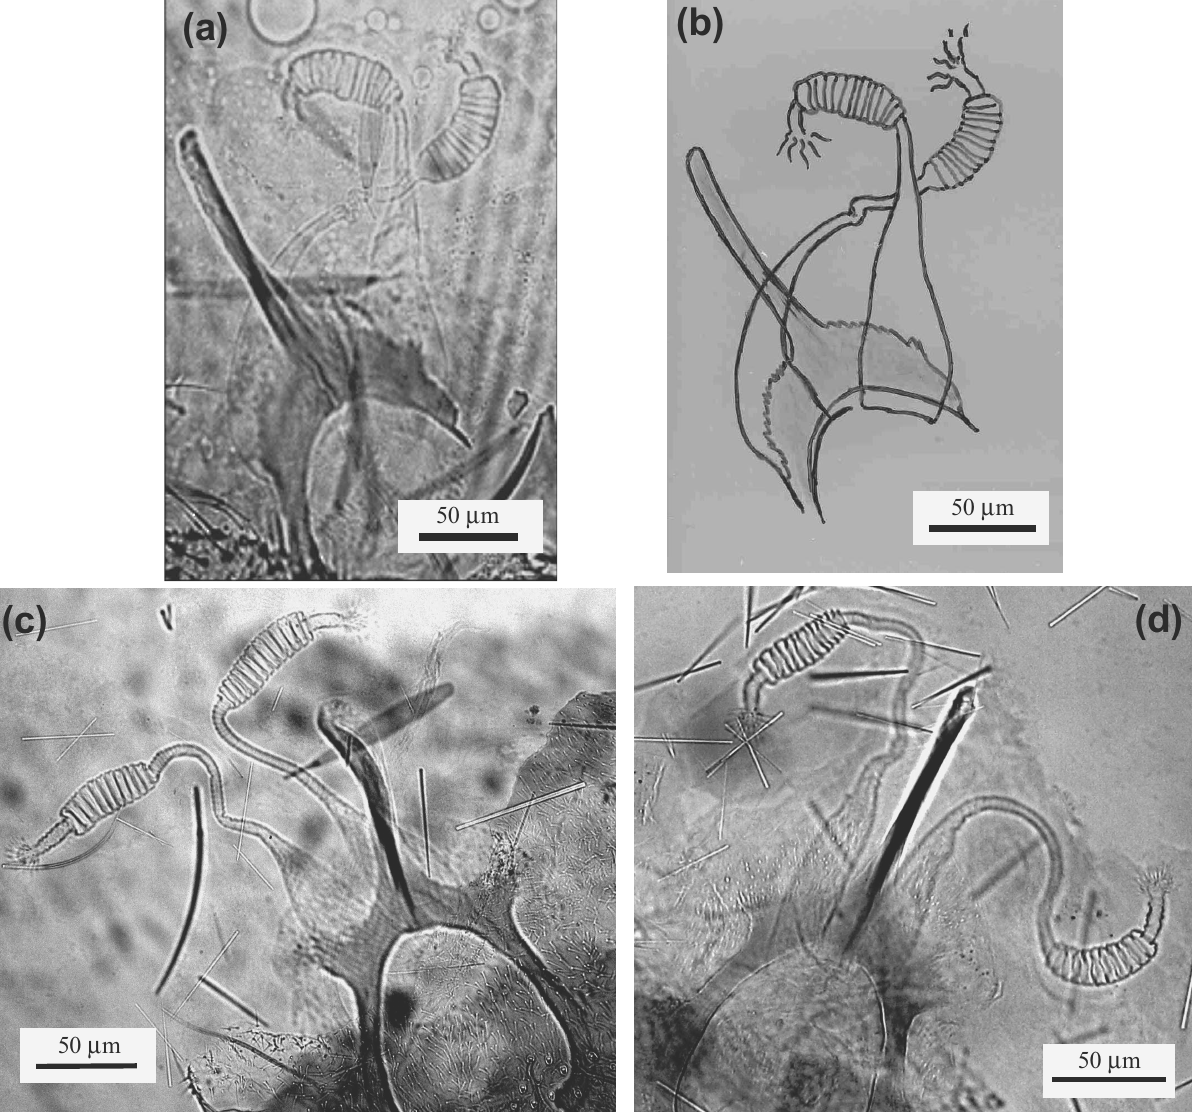
Fig. 1. – Spermathèques de Phlebotomus chadlii , photographiée (a) et dessinée (b) de P. ariasi de France (c) et du Portugal